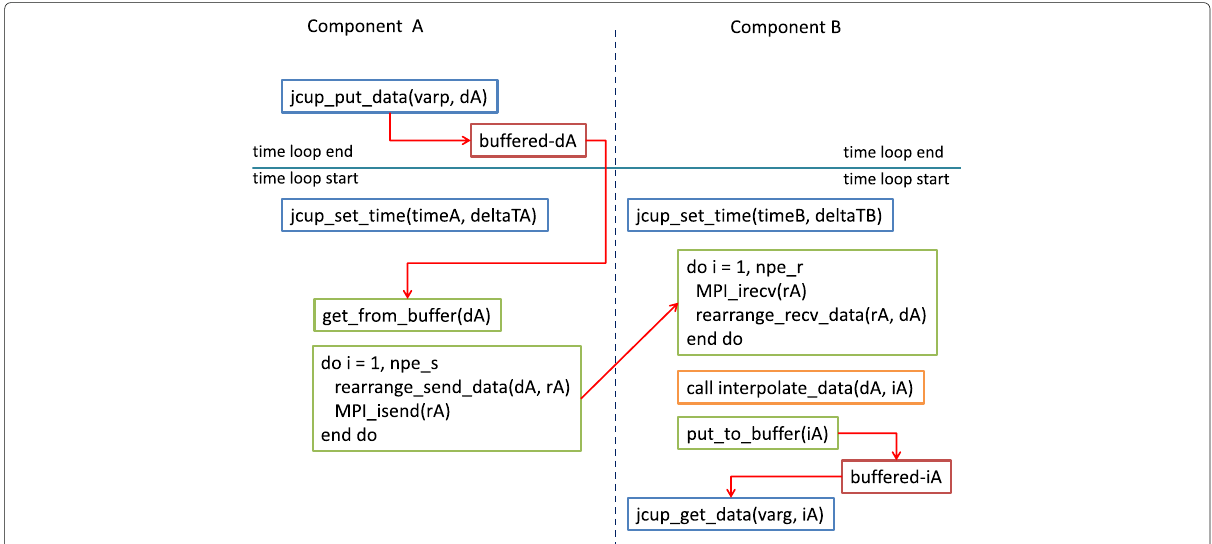
Fig. 4 Overview of API routine calls and data processing within Jcup. Blue squares indicate the API routines. Green squares mean data processing in Jcup. Orange square is a calling of interpolation subroutine interpolate_data in which the interpolation code must be implemented by